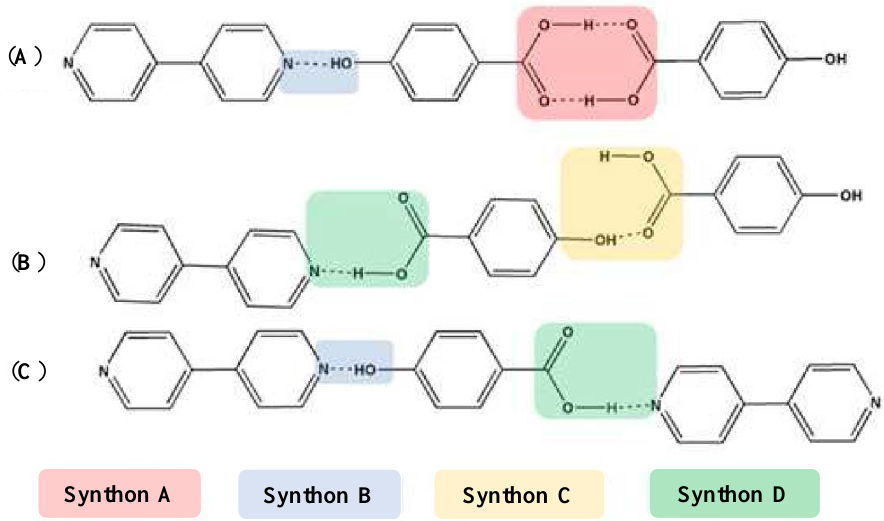
Figure 26. Synthon polymorphs of ( A ) form I, ( B ) form II and ( C ) form III 4-hydroxybenzoic acid:4, 4′ -bipyridine (2:1) cocrystal (pink—synthon A; blue—synthon B; orange—synthon C and green—synthon D) [Reprinted from [286] with permission. Copyright 2013 Royal Society of Chemistry].